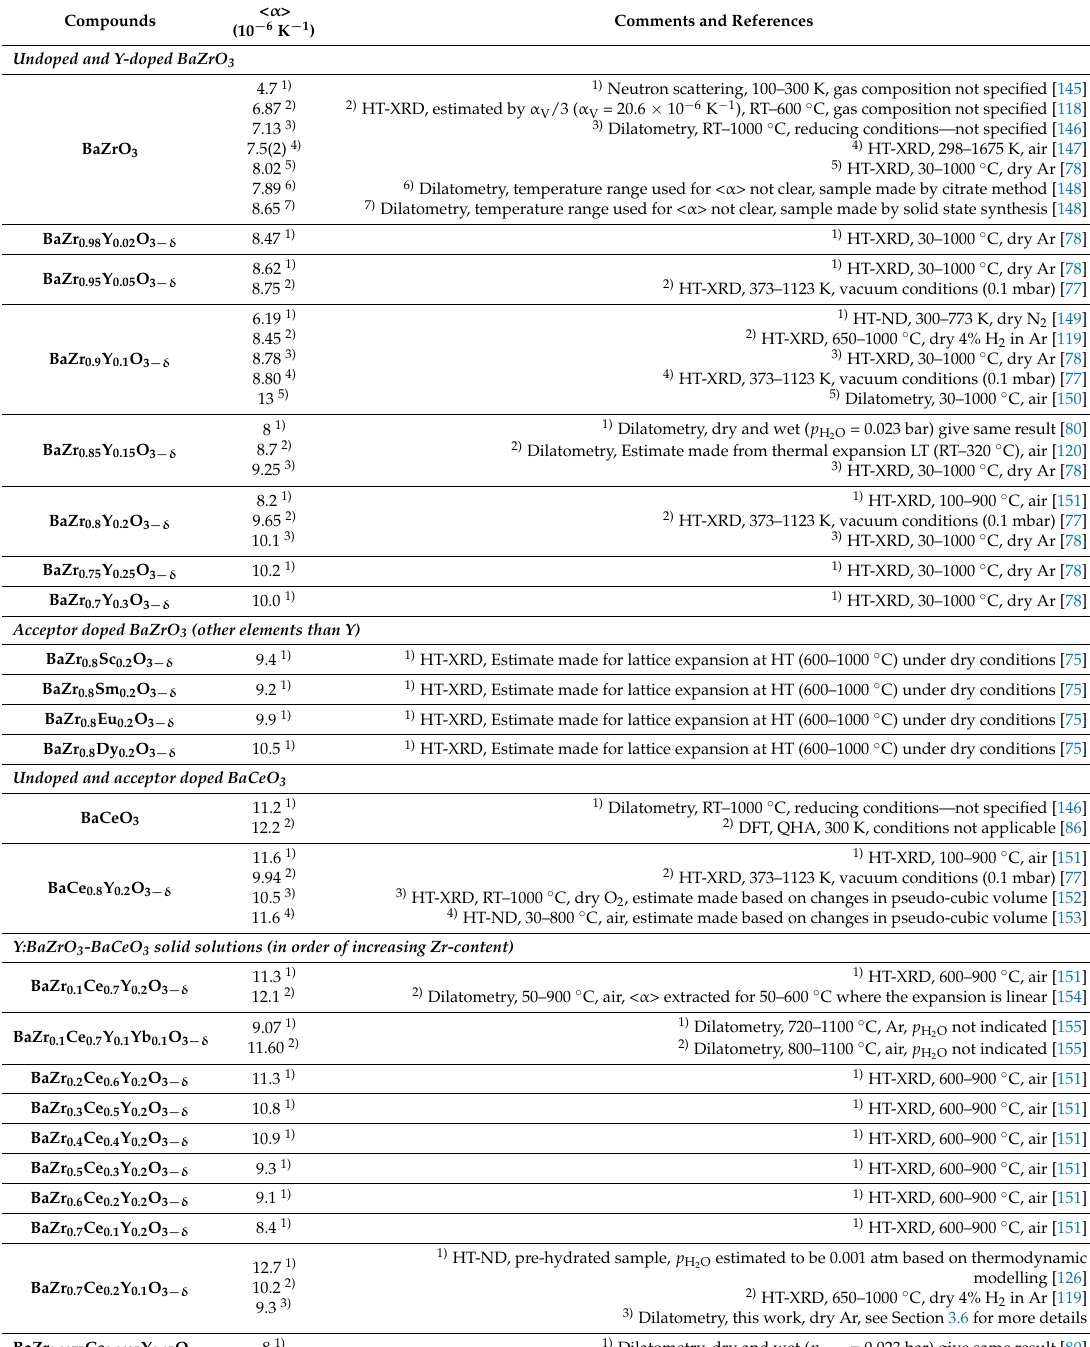
Table 2. Thermal expansion coefficients of barium zirconate and barium cerate based perovskites. < α > Compounds (10 − 6 K − 1